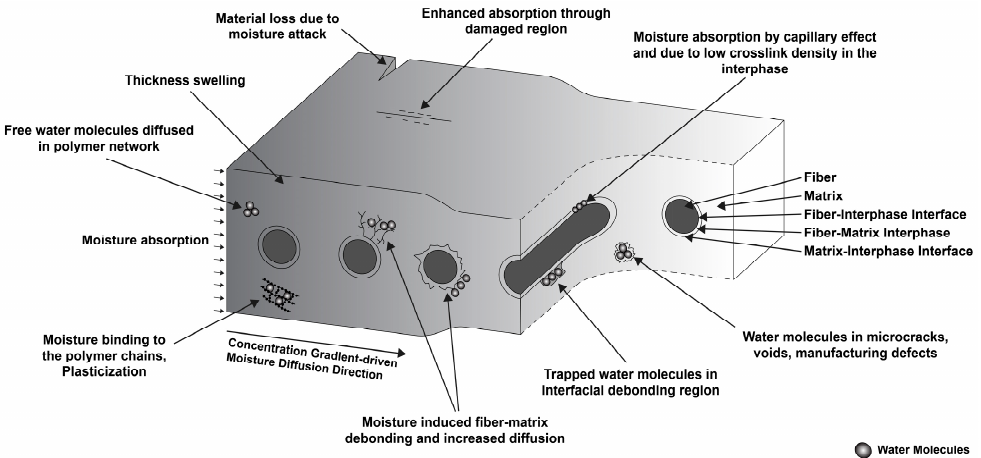
Figure 1. Schematic summary of different states of water molecules absorbed in FRP composites.